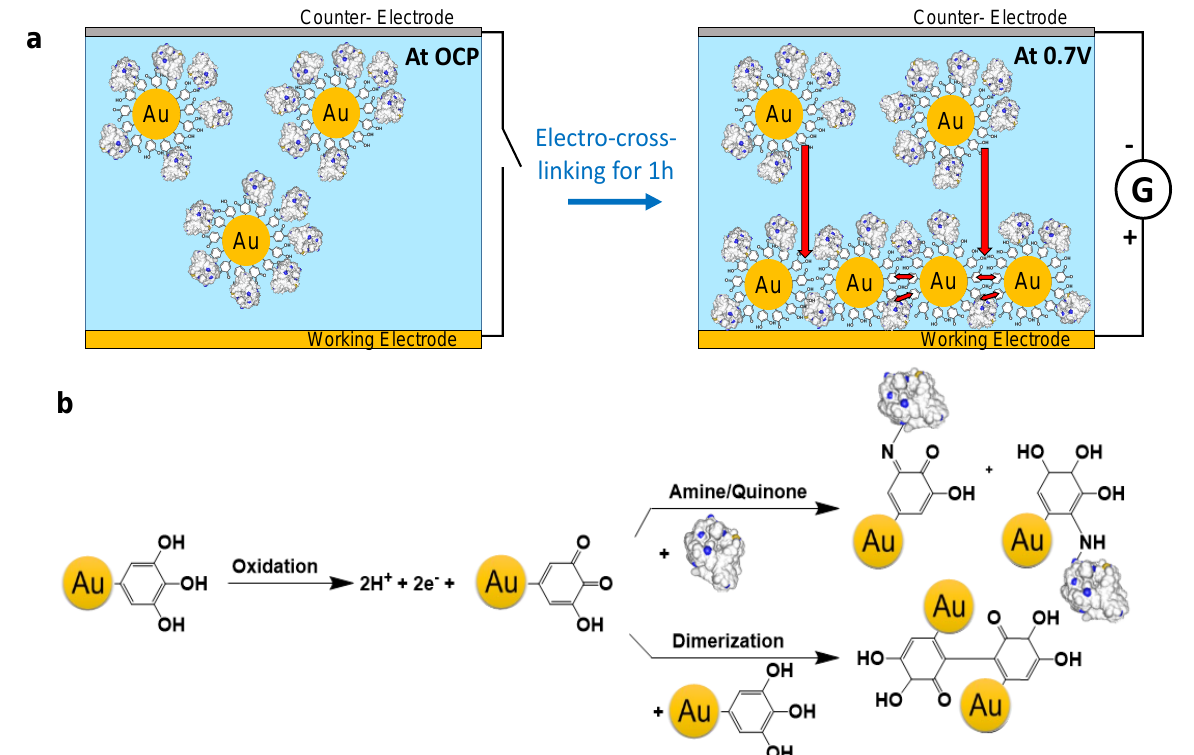
Figure 1. ( a ) Schematic representation of the electro-crosslinking of TA capped gold NPs and enzymes onto an electrode by application of an anodic potential. ( b ) Mechanism of the electro-cross-linking through electro-oxidation of gallol moieties of TA, present at the surface of NPs, into quinone. This oxidation is followed by the chemical reaction of quinone moieties with free amino moieties of the enzyme leading to imine and Michael adduct and with gallol moieties of TA (dimeriza- tion).